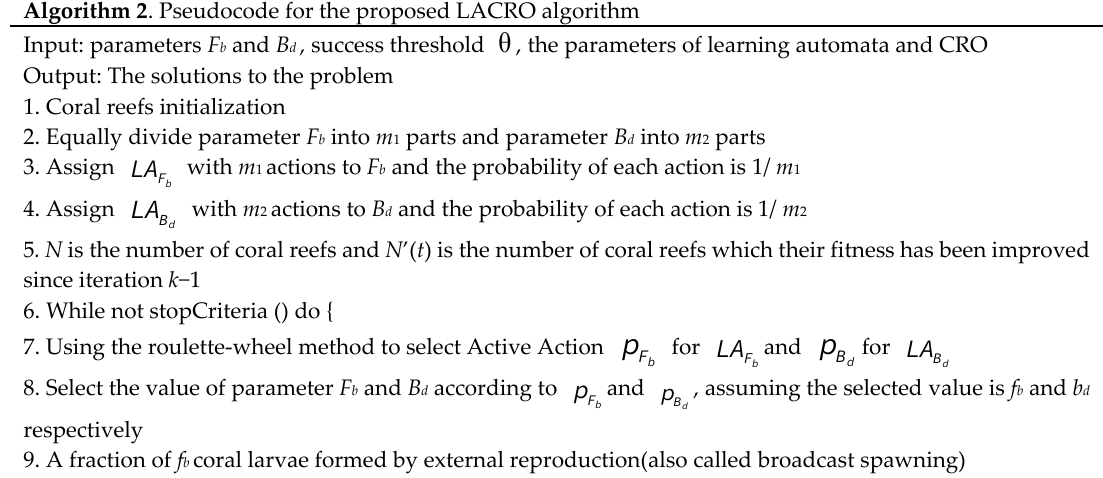
Algorithm 2 . Pseudocode for the proposed LACRO